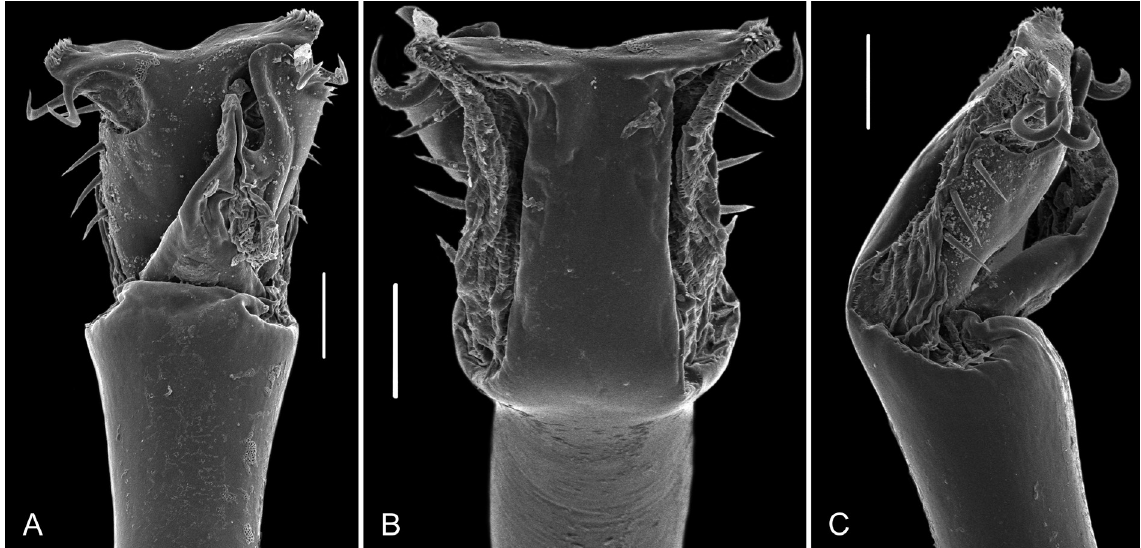
Fig. 18. Eulibitia leda sp. nov., ♂, paratype (ICN-AO 1165.1), distal part of penis. A . Dorsal view. B . Ventral view. C . Lateral view. Scale bars: 50